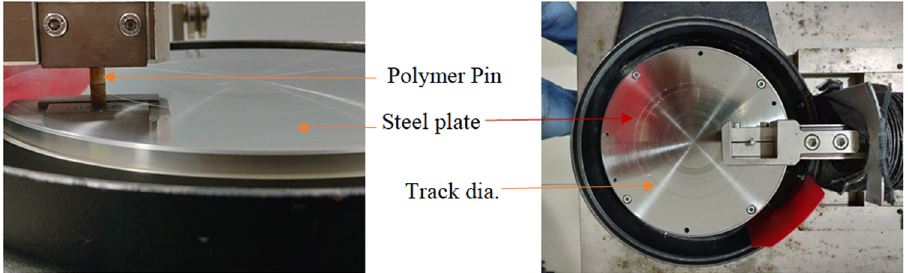
Figure 3: Pin - on - disc